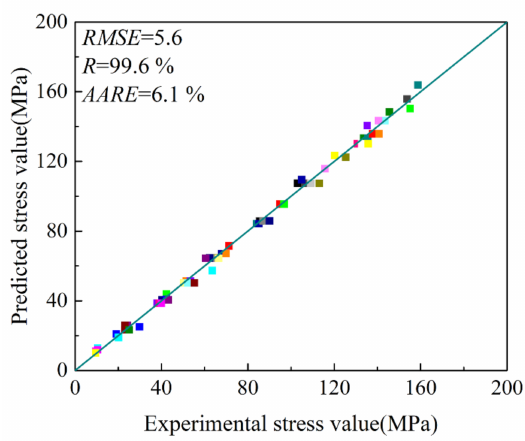
Figure 8. Correlation between the experimental and predicted flow